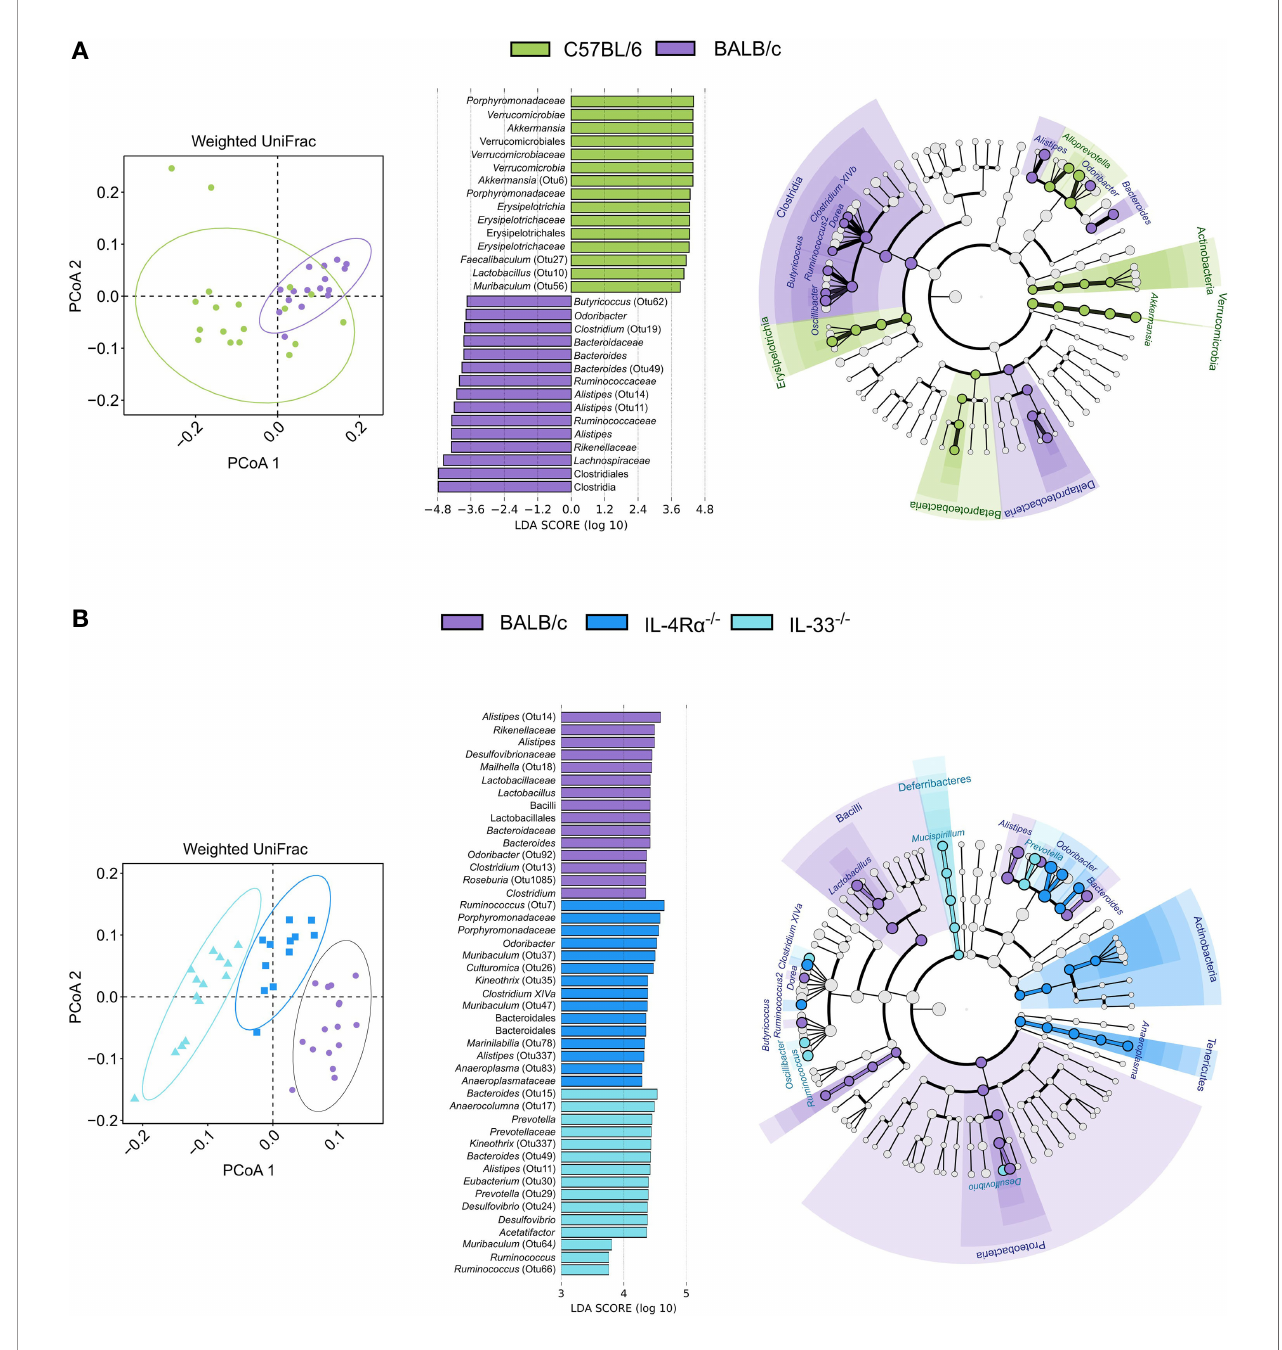
FIGURE 5 | The naïve caecal mouse microbial community is immunocompetence-speci fi c. Differences in microbial composition were assessed by AMOVA/ANOSIM, principal coordinate analysis (PCoA), and unsupervised clustering based on weighted UniFrac distances. Differentially abundant OTUs between genotypes were identi fi ed by linear discriminant analysis effect size (LEfSe, LDA > 3.0). (A) When comparing BALB/c (n = 16, purple) and C57BL/6 (n = 18, green) animals, only one cluster was observed as indicated by shapes in the PCoA despite AMOVA/ANOSIM indicating distinct differences between the two genotypes ( P ≤ 0.014). Several differentially abundant OTUs distinctly associated with each cluster were observed where members of primarily the Clostridia class and Porphyromonadaceae family were associated with BALB/c and C57BL/6, respectively. (B) By comparing BALB/c wild-type (n = 16, purple), IL-4R a -/- (n = 12, blue), and IL-33 -/- (n = 14, light blue) mice, distinct clusters were observed for each genotype as indicated by the shapes in the PCoA ( P < 0.001). Identi fi ed taxa are visualized in cladograms annotated at class and genus level, and the top 15 differentially abundant taxa for each genotype are visualized in bar plots. Additional taxonomic information can be found in Supplementary Tables 5, 8 . AMOVA, analysis of molecular variance, ANOSIM, analysis of similarities (non-parametric); OTU, Operational taxonomic unit; LDA, linear discriminant analysis score; SD, standard